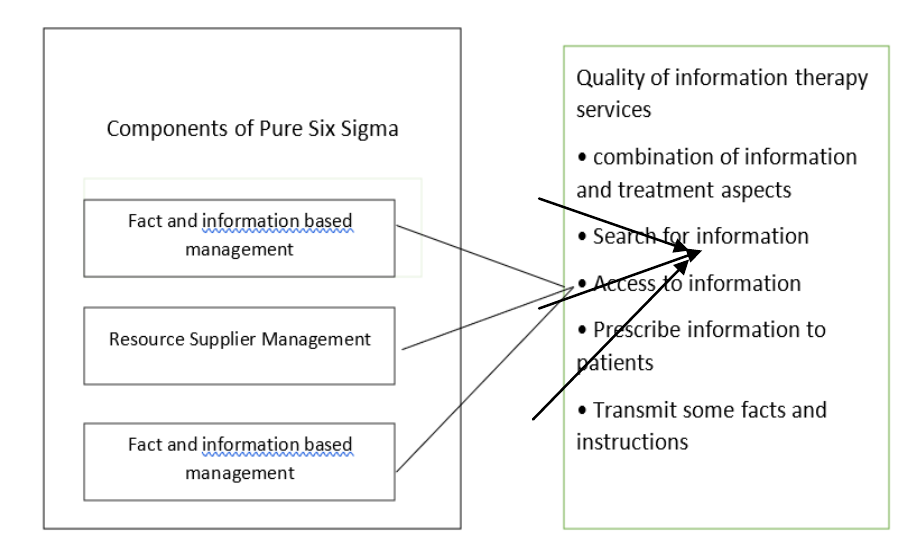
Figure 1: Conceptual model of